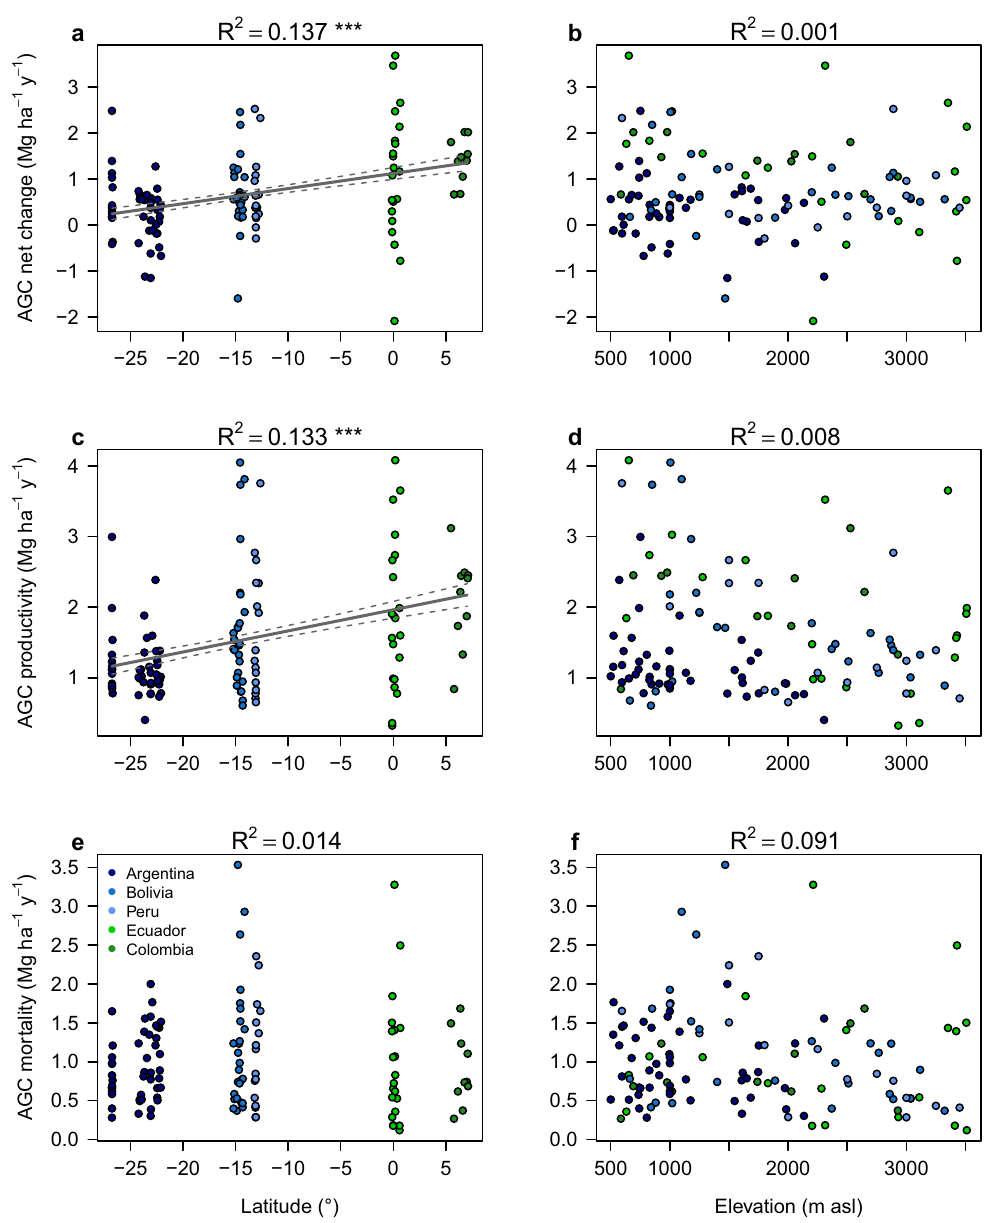
Fig. 2 Aboveground carbon dynamics along elevational and latitudinal gradients. Generalized additive models (GAMs) assessing the changes of the aboveground carbon (AGC) dynamics in relation to latitude (°) ( a , c, e ) and elevation (m asl) ( b , d , f ), across 119 forest-monitoring plots in the subtropical and tropical Andes. Negative latitudinal values represent plots in the Southern hemisphere and positive latitudinal values represent plots in the Northern hemisphere. Solid lines represent the models that were statistically signi fi cant and da shed lines represent 95% con fi dence intervals. * P ≤ 0.05; ** P ≤ 0.01; *** P ≤ 0.001. AGC net change = aboveground carbon net change (Mg C ha − 1 y − 1 ). AGC productivity = aboveground carbon productivity (Mg C ha − 1 y − 1 ). AGC mortality = aboveground carbon mortality (Mg C ha − 1 y − 1 ). R 2 = Coef fi cient of determination of the